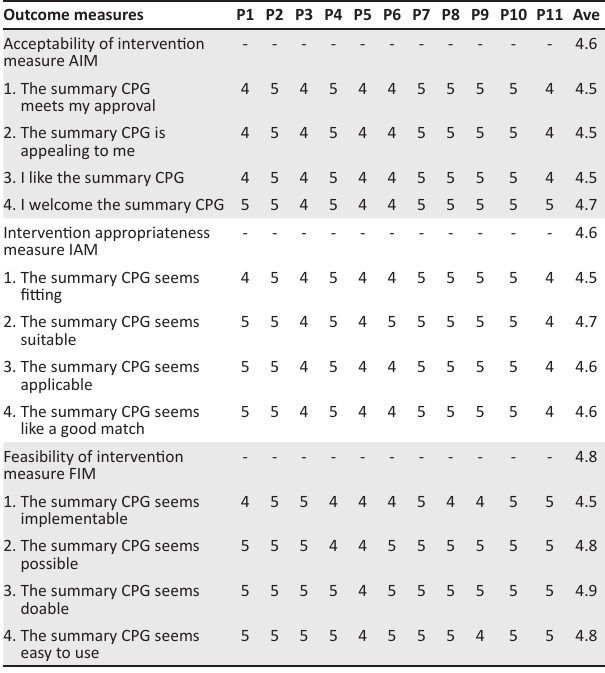
TABLE 2: Results of outcome measures. Outcome measures Acceptability of intervention measure